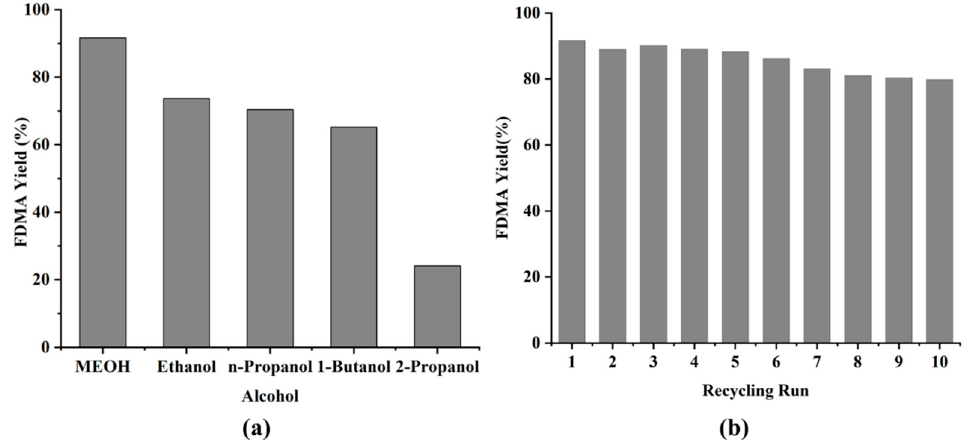
Figure 8. ( a ) Effect of alcohol on the FUR acetalization catalyzed by MCS . ( b ) Reuse of MCS catalyst in FUR acetalization.